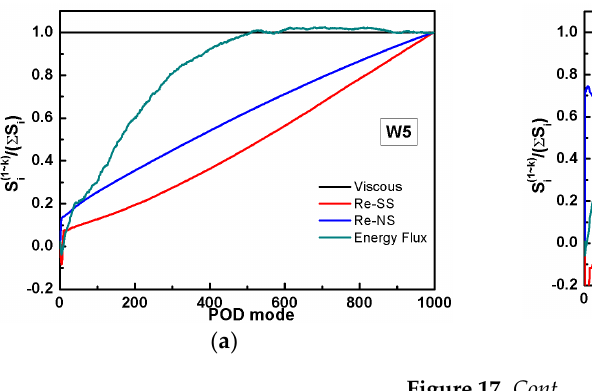
Figure 16. Entropy generation of third order mode: ( a ) the Reynolds sheer stress term; ( b ) the Reynolds normal stress term; and ( c ) the energy flux term.